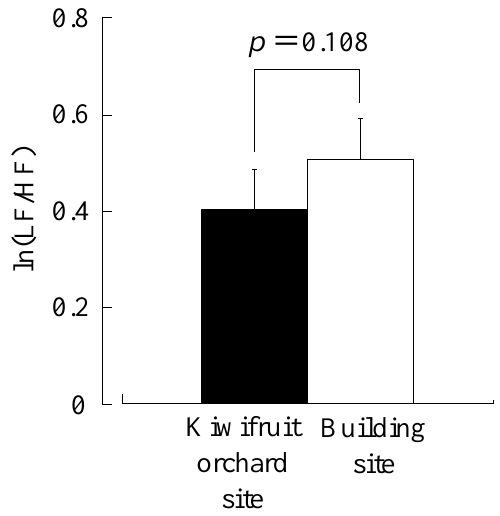
Figure 4. Comparison of the natural logarithmic value of the low frequency (LF)/high frequency power ratio of heart rate variability during 10-min viewing of kiwifruit orchard or a building site. Date are expressed as the means ± standard error (SE); n = 17. p -value by the paired t -test (one-sided).